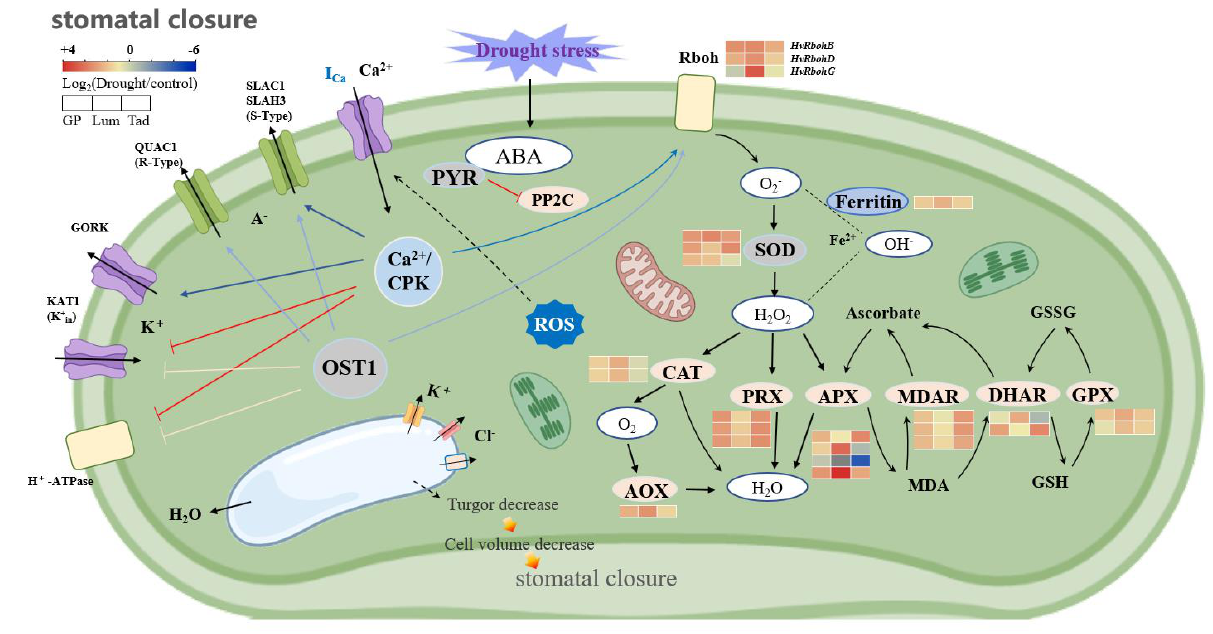
Figure 9. A hypothetical working model of underlying stomatal closure mechanisms in Lum. The relative expression levels of genes encoding different enzymes are shown by a color gradient from low (blue) to high (red). For each heatmap, from left to right: GP (first column), Lum (second column), Tad (third column). Rboh—NADPH oxidase enzyme; PYR—ABA receptors; PP2Cs—2C-